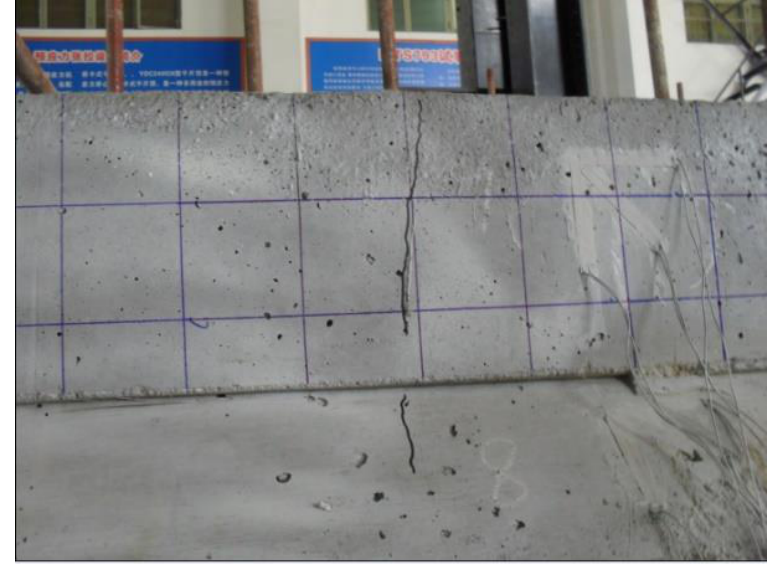
Figure 9. The concrete crack in CJA.